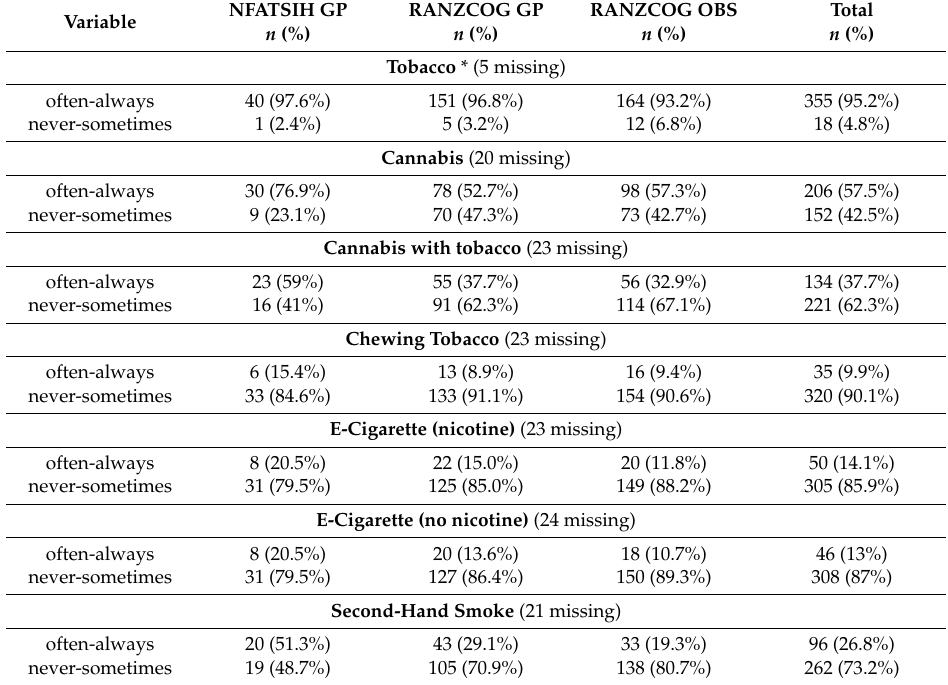
Table 2. Proportions of GPs and Obstetricians who ask about exposures to tobacco, cannabis, chewing tobacco, e-cigarettes, and Second-Hand